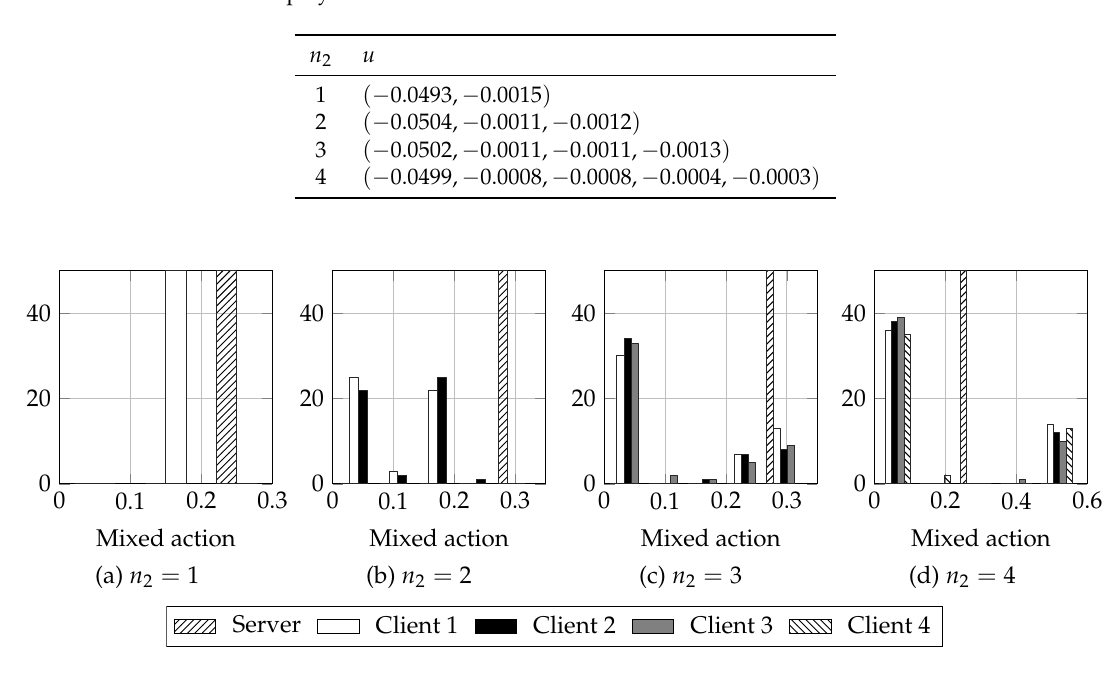
Figure 4. Histogram of actions obtained using RM algorithm, for n = 5 stations and variable number of malicious stations. Each histogram is computed using 5 bins. Cl stands for client. Observe that the action of the server does not vary significantly, whereas the actions of the clients do. Also, observe how as n 2 increses, the clients histogram presents two peaks: the biggest close to 0 and a smaller peak at another mixed action value. This hints that the game tends to the two player case when there are many clients: all but one client tend to behave as normal stations.